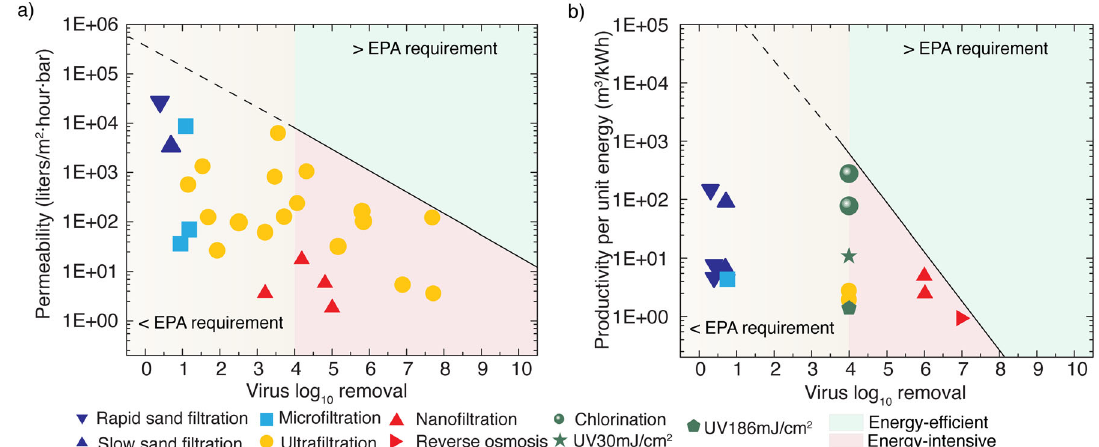
Fig. 1 A pathogen removal vs. productivity trade-off exists in virus fi ltration techniques widely used in water treatment illustrating the challenge with virus removal. a The permeability vs. virus retention ef fi ciency of widely used fi ltration technologies shows that a trade-off exists between the pathogen removal and permeability due to the dependence on size-exclusion. The tabulated data with references is available in Supplementary Table 4. b The operational energy requirement of fi ltration techniques and total energy requirement of disinfection techniques (except for chlorination) considering a combination of operational energy and embedded chemical energy is comparable. This indicates that fi ltration techniques can potentially achieve similar performance as disinfection, speci fi cally if the virus removal ef fi ciency can be increased without incurring substantial additional operational energy costs. A detailed summary of the literature survey and energy requirement values used can be found in Supplementary Table 5 and Supplementary Note Fig. 2b, c indicated that the fi bers procured from local sources exhibit similar characteristics as standard fi ber samples 24 .